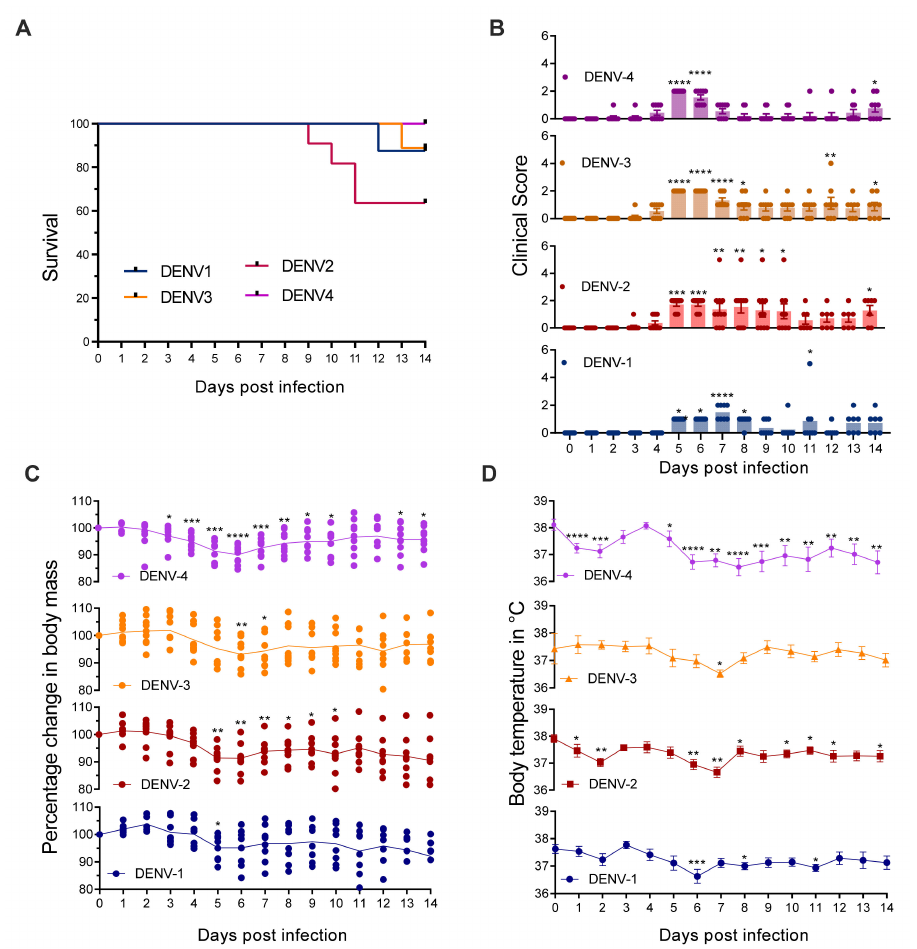
Figure 2. Kit W-sh/W-sh Ifnar1 − / − Ifngr1 − / − mice are susceptible to DENV infection. Mice ( n = 8–11) were infected i.p. with 1 x 10 6 PFU of DENV1, DENV2, DENV3, or DENV4 (EDEN strains). ( A ) Survival curve for adult Kit W-sh/W-sh Ifnar1 − / − Ifngr1 − / − ( B ) Clinical score of DENV infected mice 1: ruffled fur, 2: hunch back, 3: diarrhea, 4: paralysis and moribund 5: death. ( C ) Change in body mass, Line represents the average, and dots represent individual mouse and ( D ) temperature following DENV infection. Data represent mean ± SEM, * p < 0.05, ** p < 0.01, *** p < 0.001, and **** p < 0.0001, by one-way ANOVA with Dunnett’s